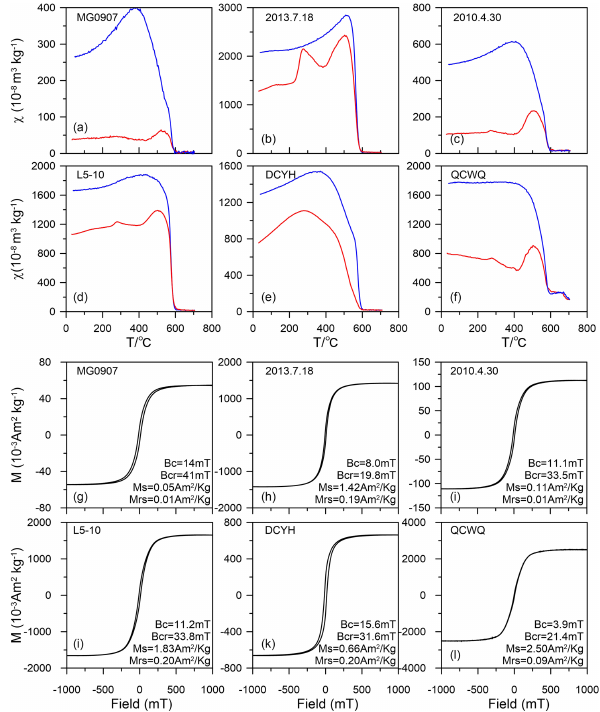
Figure 3. χ − T heating (red line) and cooling (blue line) curves (a–f) and magnetic hysteresis loops (g–l) of representative sam- ples of natural surface sediments (MD0907), atmospheric dustfall (2013.7.18 and 2010.4.30), street dust (L5-10), and anthropogenic pollutants: fly ash (DCYH) and vehicle exhaust (QCWQ).